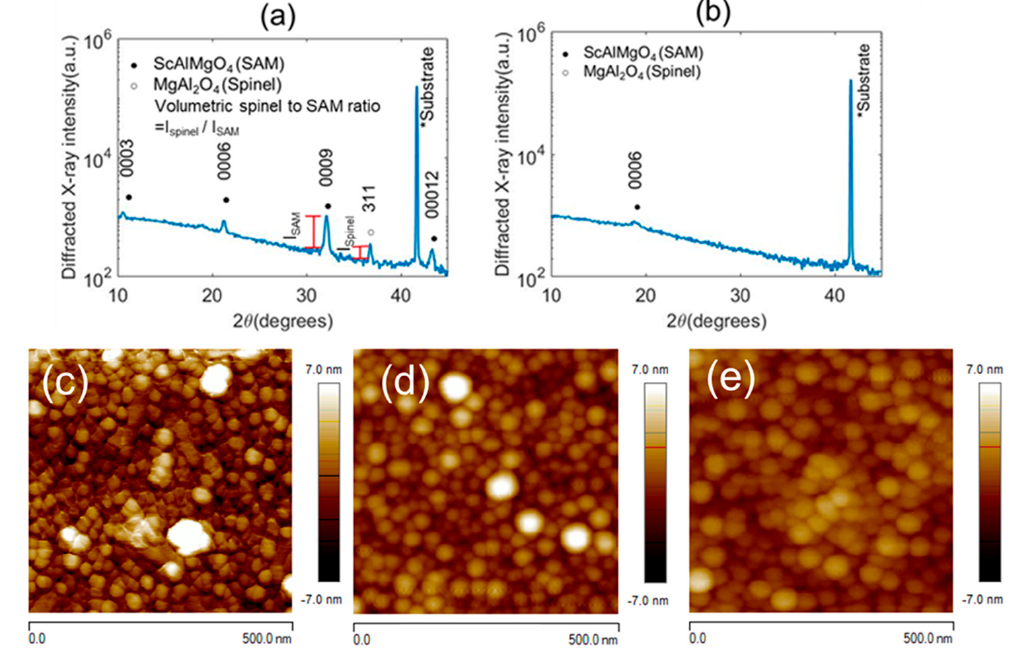
Figure 2. X-ray diffraction ω –2 θ scans of annealed SAM layer on ( a ) pre-annealed sapphire (Sample A) and ( b ) unannealed sapphire (Sample B). AFM images of ( c ) crystallized Sample A, with RMS roughness of 1.57 nm, ( d ) amorphous Sample A, with RMS roughness of 1.16 nm, and ( e ) Sample B (not fully crystallized), with RMS roughness of 1 nm.